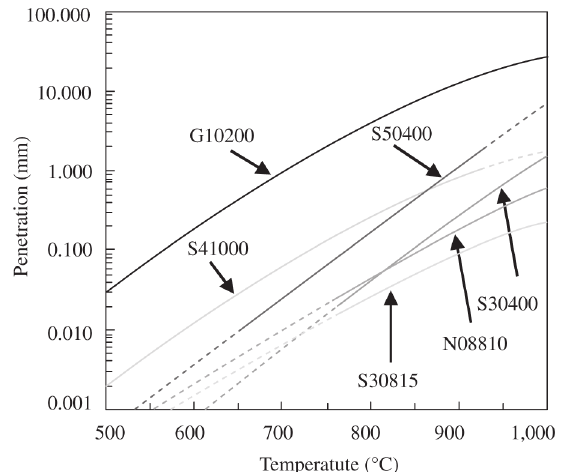
Figure 2. Effect of Temperature Upon Metal Penetration of Some Common Alloys by Oxidation After Exposure for One Year to Air (P O of 0.21 atma). 2